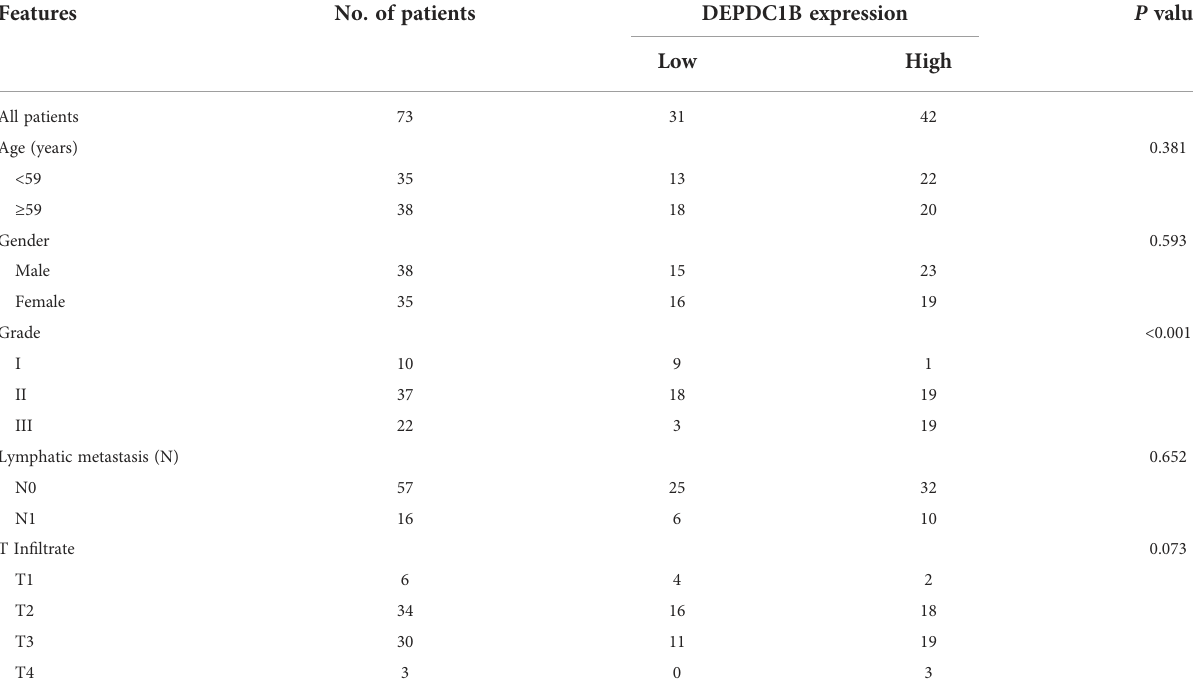
TABLE 2 Relationship between DEPDC1B expression and tumor characteristics in patients with CCA.